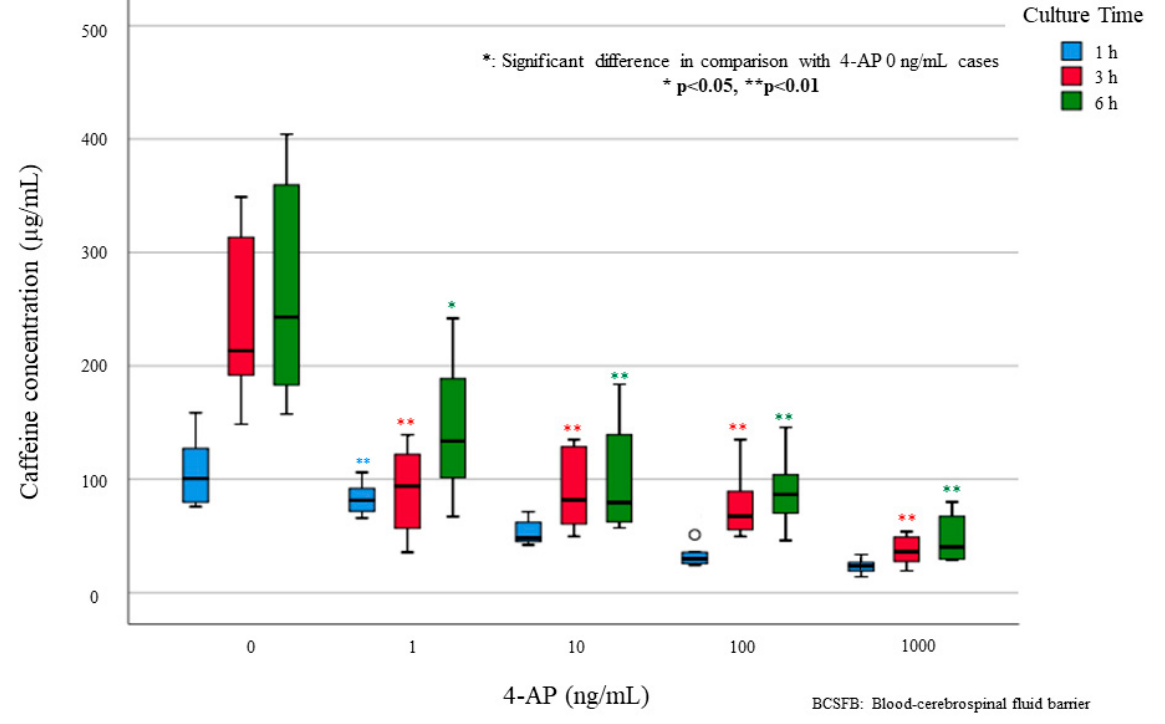
Figure 3. Concentration of caffeine after the addition of 4-AP by the time after administration of each concentration of 4-AP in the BCSFB model. Table 2. Changes in the concentration of caffeine (µg/ mL ) in the CSF side after each 4-AP admin- istration in the BCSFB model.